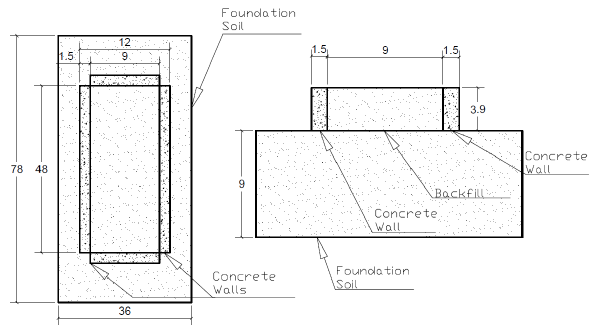
Figure 1: Geometrical model : plan view (left side) and cross section (right side).